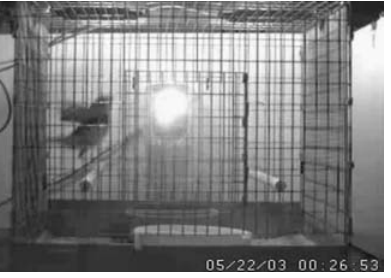
the spring (March–June) and fall (August–December), when